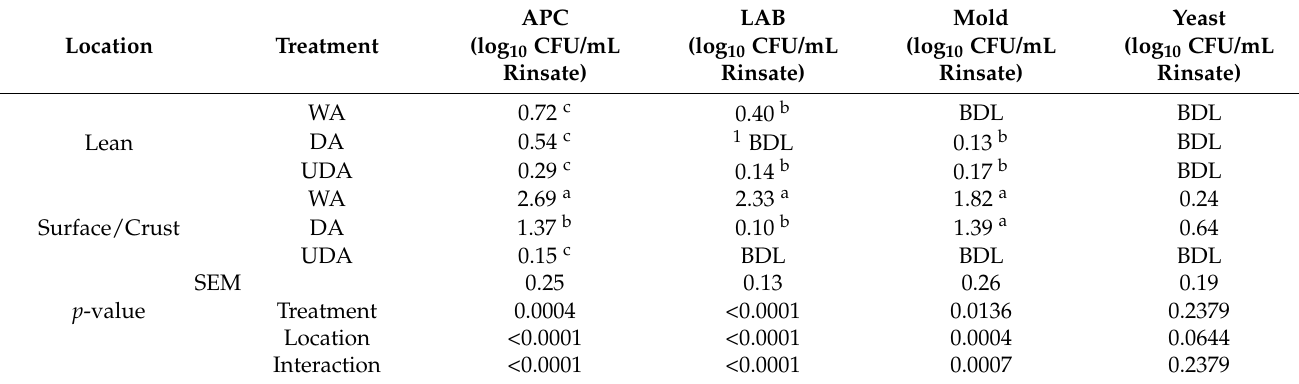
Table 3. Effect of different aging treatments on total aerobic bacteria (APC), lactic acid bacteria (LAB), and mold and yeast concentration on the crust (surface) and the lean portion of pork loins ( M. Longissimus lumborum ) aged for 21 days.